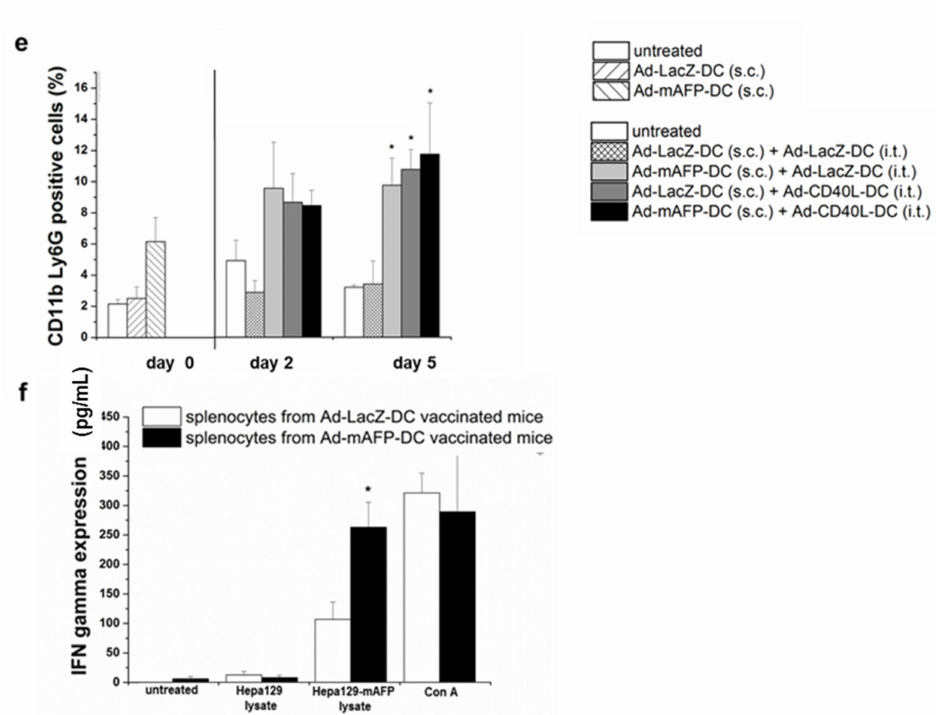
Figure 5. Intratumoral immune cell recruitment. ( a – e ) Percentage of CD4 + -, CD8 + -T-cells, DC, Treg and MDSC within the total tumor cell suspension was analyzed via flow cytometry. Mice were treated with the heterotopic combination of a s.c. vaccination with 10 6 Ad-mAFP-DC or Ad-LacZ- DC followed by an i.t. injection of 10 6 Ad-CD40L-DC or Ad-LacZ-DC. Analysis of immune cell recruitment was performed on day 0 (after the s.c. vaccination before i.t. injection of Ad-CD40L- DC), on day 2 and 5 after the i.t. injection of Ad-CD40L-DC. Results represent means ± SEM of three independents experiments ( n = 8). (* p < 0.05 compared to s.c.-Ad-LacZ-DC/i.t.-Ad-LacZ-DC group). ( f ) Splenocytes were isolated 3 months after s.c. Ad-mAFP-DC or Ad-LacZ-DC vaccination, re-stimulated with tumor cell lysates for 24 h and quantified for IFN γ -secretion by ELISA. Data are given as mean ± SEM. Graphic shows one representative experiment ( n = 6 each group) from two different experiments. (* p < 0.05 compared to s.c.-vaccination with Ad-LacZ-DC splenocytes). Con A: Concanavalin A. Significance was determined using the Mann-Whitney-test or the paired t -test ( f